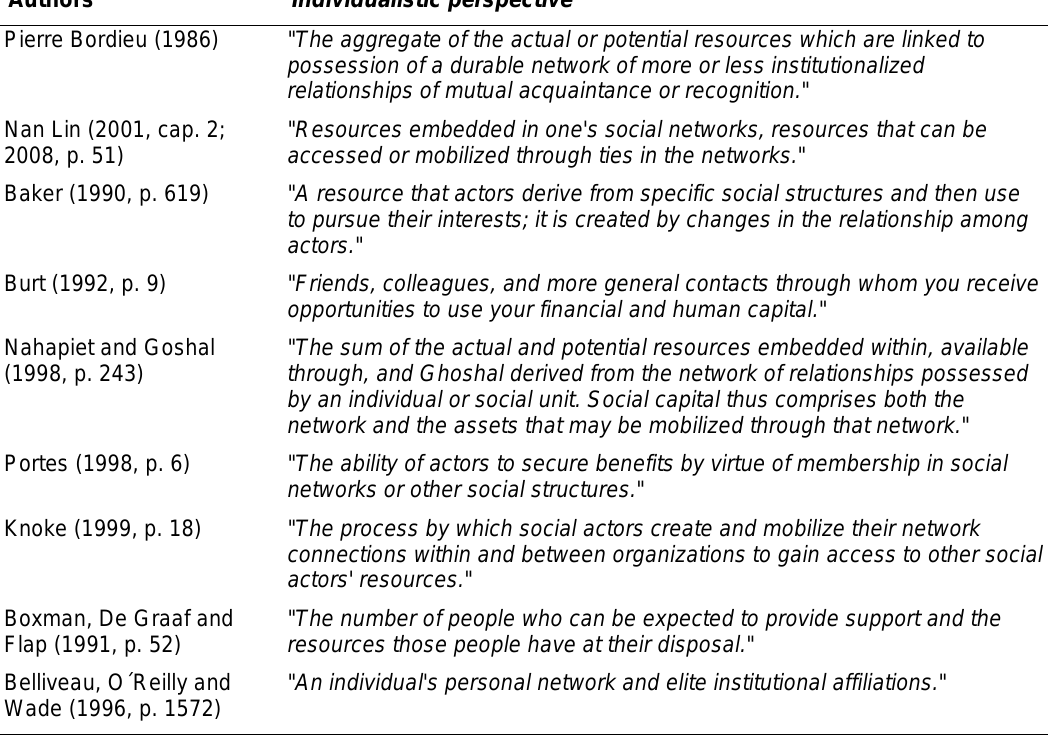
Table 1 . Definitions of social capital in the individualistic